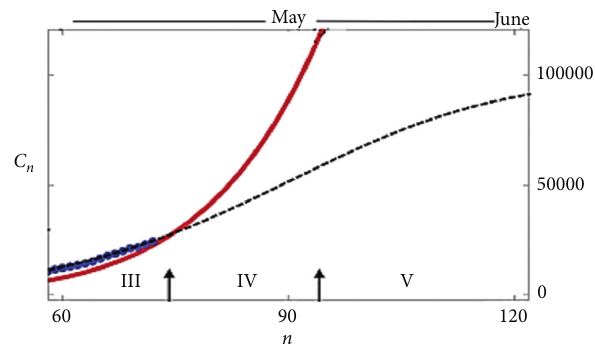
Figure 4: Confirmed COVID-19 ( C end of